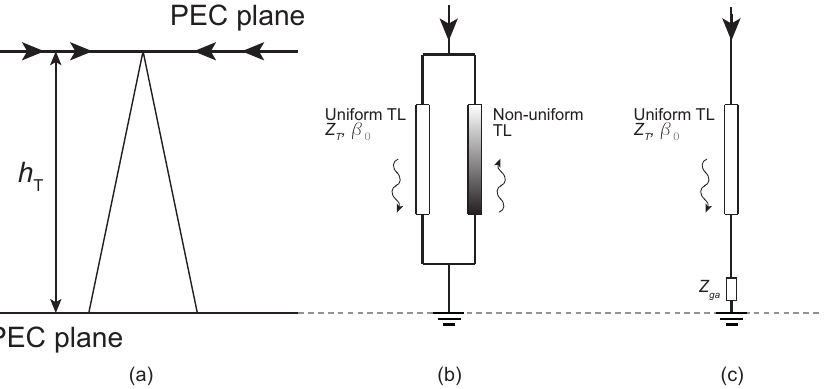
Figure 7. Cone approximation of a transmission tower with current injected horizontally at the top. ( a ) Simplified model; ( b ) Equivalent transmission line model, as proposed by Baba and Rakov [82] including a non-uniform transmission line to account for reflected waves and non-spherical reflected field; ( c ) equivalent uniform transmission line model proposed in [75,83] including a fictitious ground plane impedance Z ga .